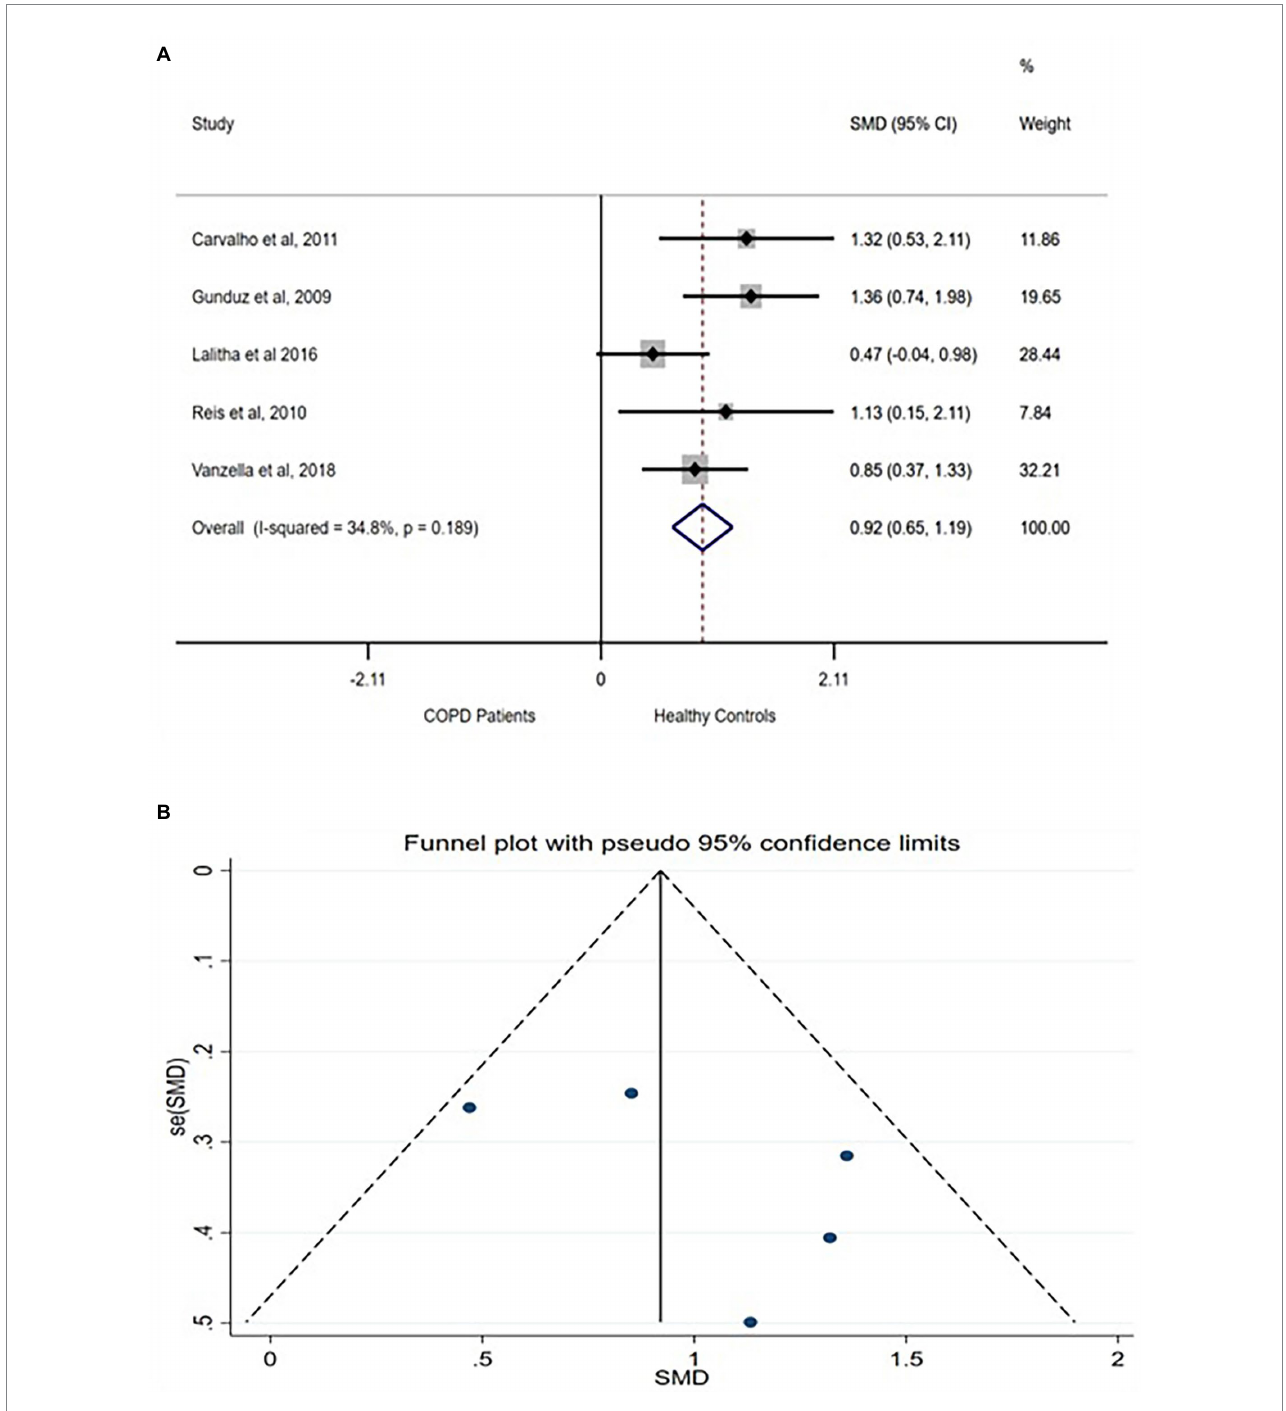
FIGURE 3 rMSSD forest plot (A) showing the SMD and funnel plot (B) assessing the presence of publication